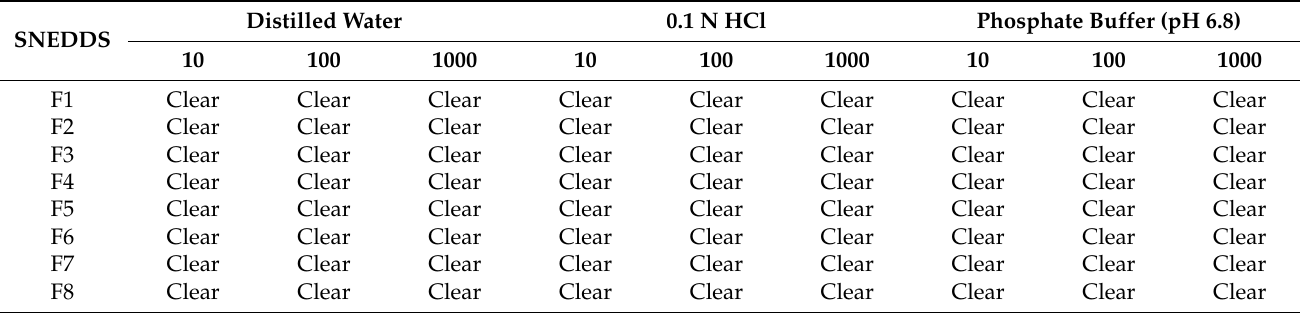
Table 4. Robustness to dilution of the drug-loaded SNEDDS.